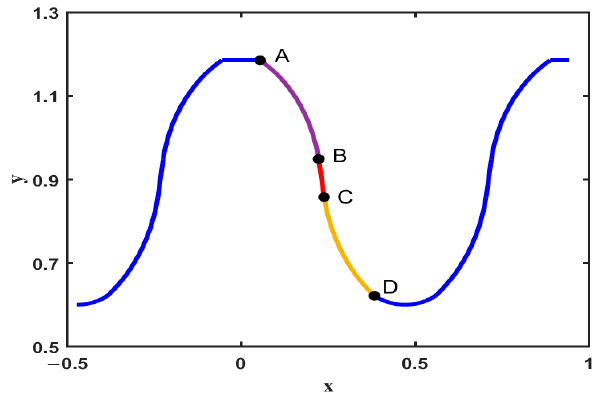
Figure 3. Tooth profile of the fitted flexspline.